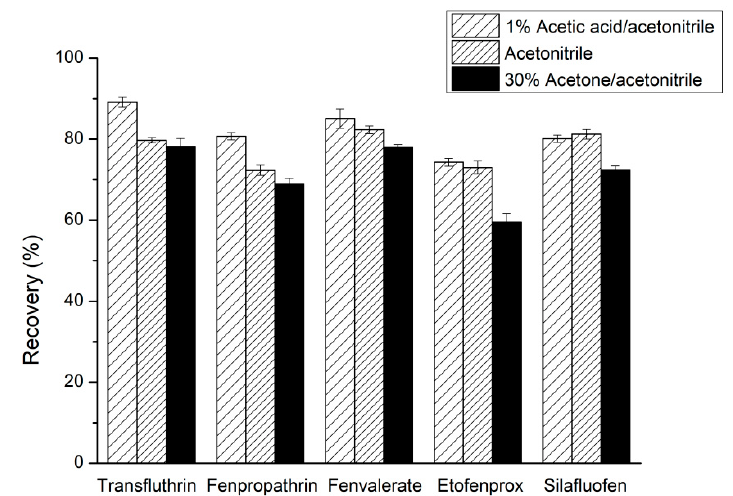
Figure 1. Effect of extraction solvent type on the recoveries of five pyrethroids.